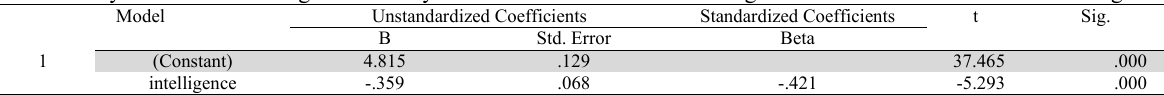
The summary of the results of regression analysis between lack of human intelligence and ethics-based decision making Model